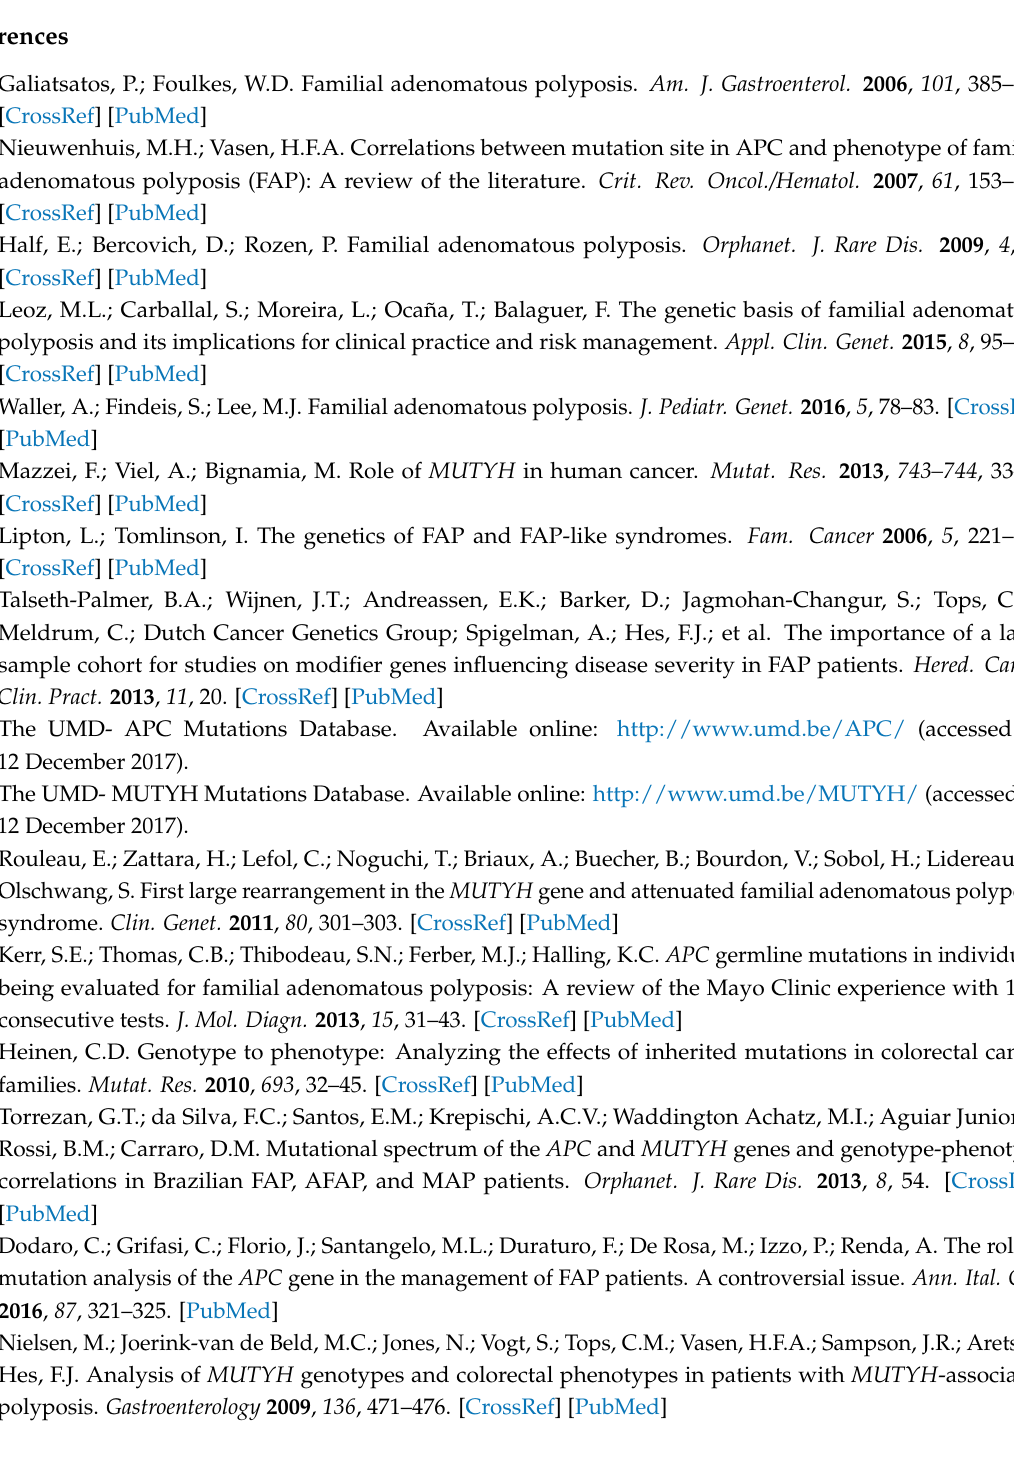
Table S1: Clinical data, mutations and UVs of APC and MUTYH in FAP probands. Figure S1: Localization of APC mutations, genotype-phenotype correlation and occurrence of extra-colonic